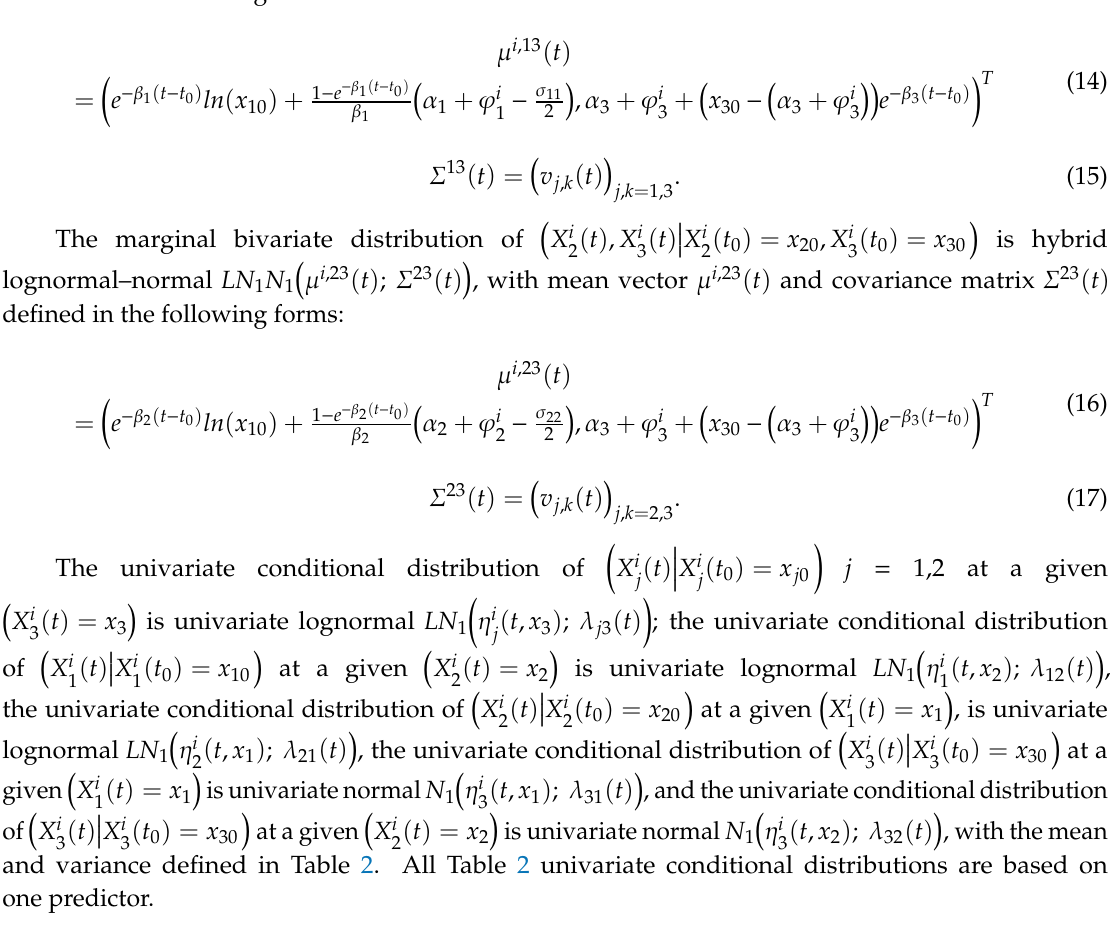
Table 2. Mean and variance of conditional probability density functions with one predictor. Probability